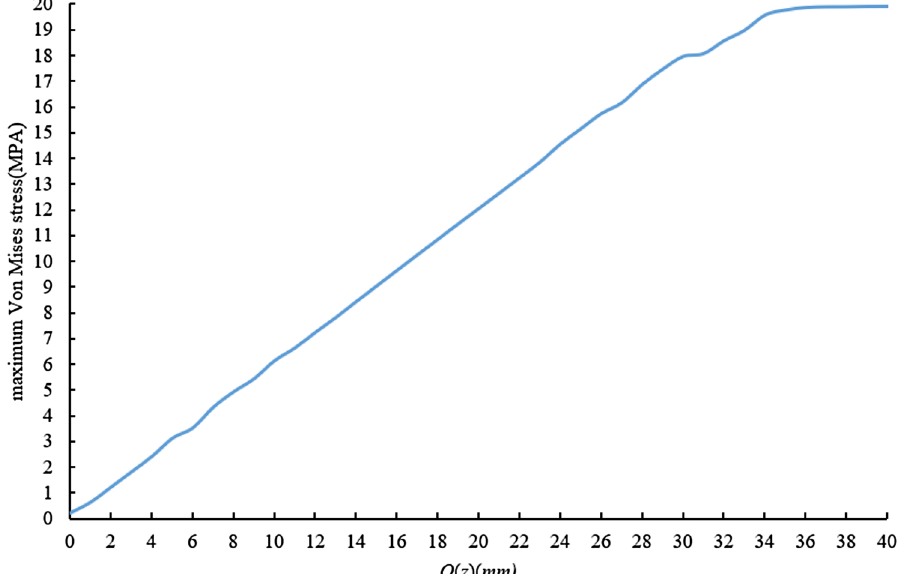
Fig. 7 Maximum Von Mises stress at each step